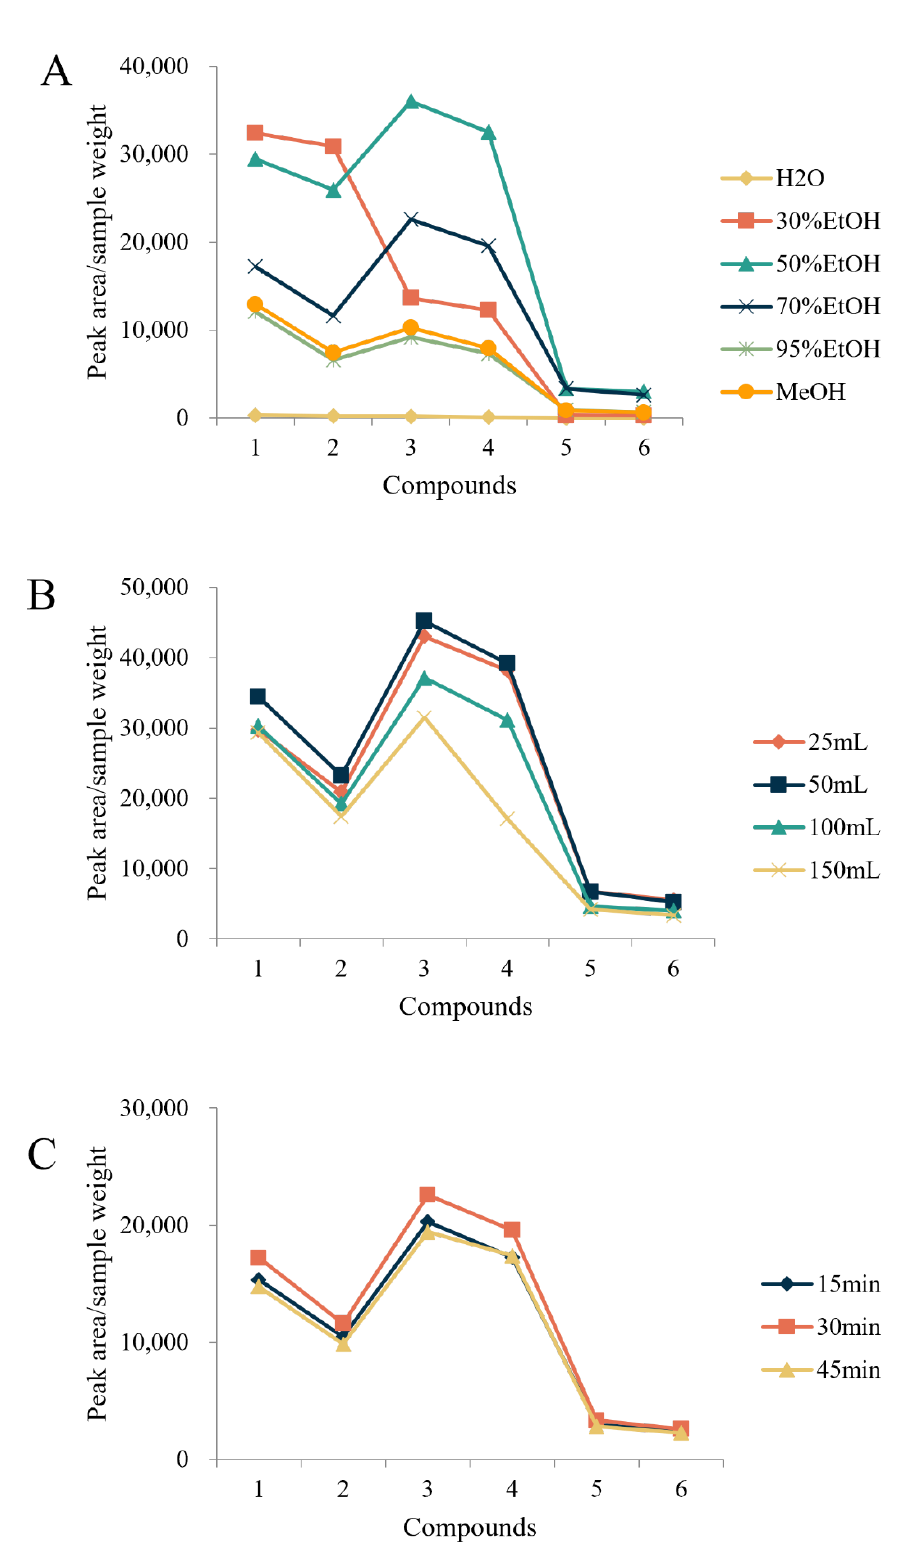
Figure 1. Optimization of the different parameters of the free dianthrones sample solution: ( A ) types of extractants, ( B ) volume of extractant, and ( C ) ultrasound time. Compounds: trans -emodin-emodin dianthrones (1), cis -emodin-emodin dianthrones (2), trans -emodin-physcion dianthrones (3), cis -emodin-physcion dianthrones (4), trans -physcion-physcion dianthrones (5), and cis -physcion-physcion (6).